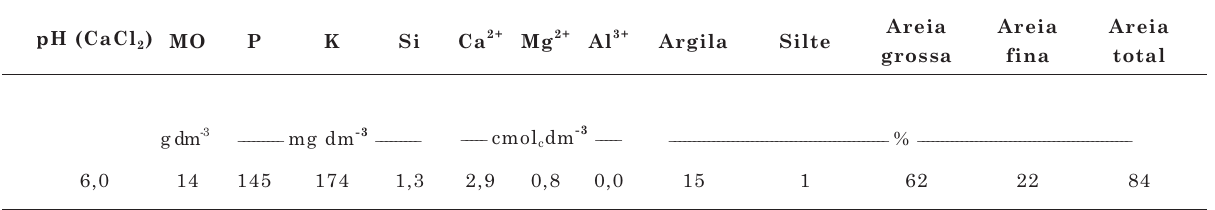
Silício extraído com CaCl 0,5 mol L -1 (Kondorfer et al., 1999); P e K extraídos com HCl 0,05 mol L -1 + H 2 Ca 2+ e Mg 2+ extraídos com KCl 1 mol L -1 ; MO = massa orgânica (Walkley-Black). (Vettori, 1969). (2) Análise textural método da pipeta, Embrapa